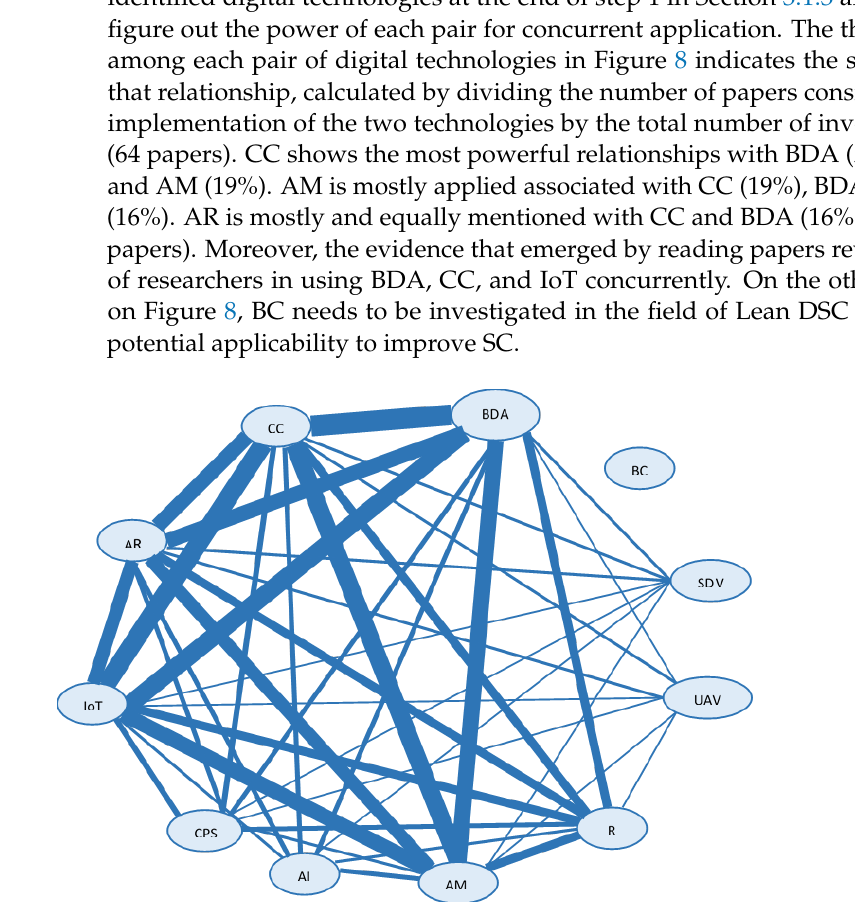
Figure 7. Distribution of papers: SC-applied methodologies. (d)